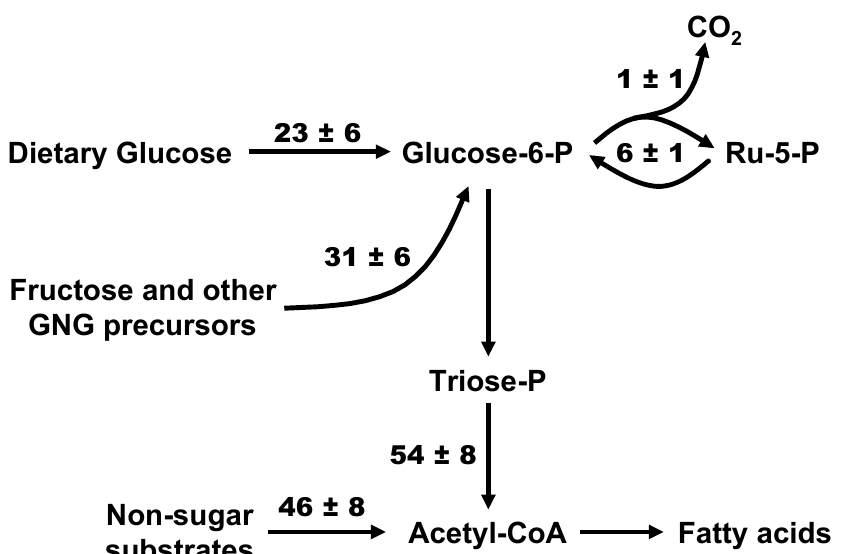
Figure 3. Fractional contributions of sugar and non-sugar sources to lipogenic acetyl-CoA estimated by combining the data of both [U- 13 C]glucose (n = 4) and [U- 13 C]fructose (n = 5) analyses. Fractional values were adjusted to that of acetyl-CoA conversion to fatty acids (arbitrarily set to 100) and the standard deviations are shown alongside the means. Table 2. Estimates of substrate fluxes contributing to lipogenic acetyl-CoA expressed as a fraction of total lipogenic acetyl-CoA flux into fatty acid synthase from 2 H enrichment and 13 C-isotopomer analysis of a group of mice provided with 2 H 2 O and [U- 13 C]glucose tracers (n = 4), and a group provided with 2 H 2 O and [U- 13 C]fructose (n = 5). The estimated pentose phosphate pathway (PPP) fluxes involved in glucose-6-P oxidation and carbon recycling to regenerate glucose-6-P (Glucose-6-P → PPP → Glucose-6-P) are also shown. Pathway Component [U- 13 C]Glucose